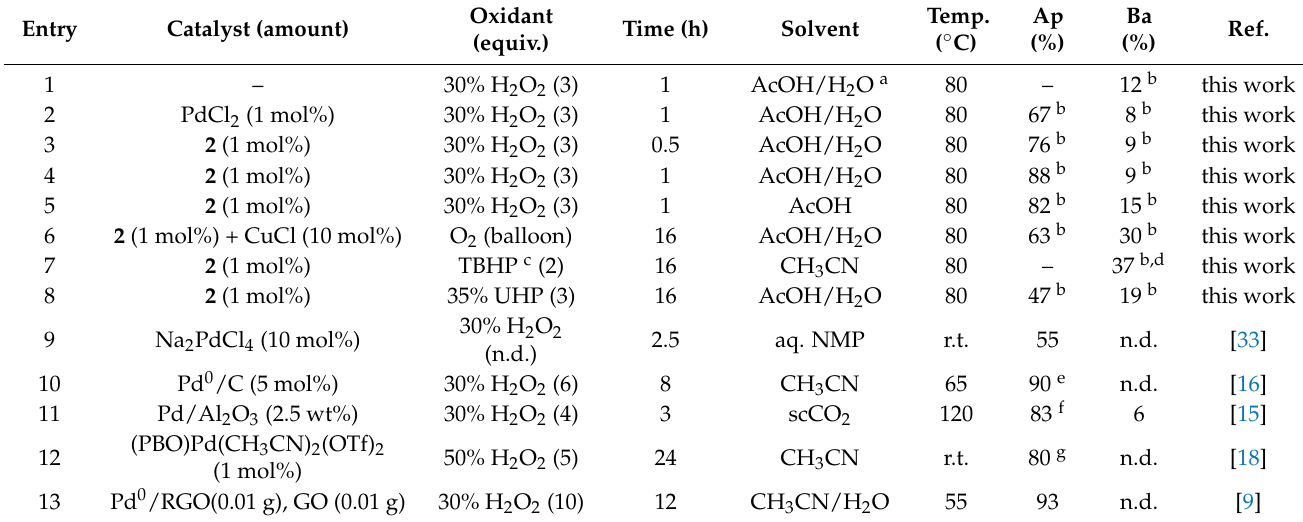
a The amounts of AcOH:H b Isolated yield. c 70% solution of TBHP in H d 47% of styrene 2 O in all reactions were 1.4:0.6 mL. 2 O was used. oxide was found. e 0.2 eq. H 2 SO 4 was used as an additive. f 53% conversion of styrene. g 92% conversion of styrene. Abbreviations: n.d.: not determined; AcOH: acetic acid; UHP: urea hydrogen peroxide; NMP: N-methyl-2-pyrrolidone; scCO 2 : supercritical CO 2 ; PBO: 2-(2-pyridyl)benzoxazole; OTf: triflate; RGO: reduced graphene